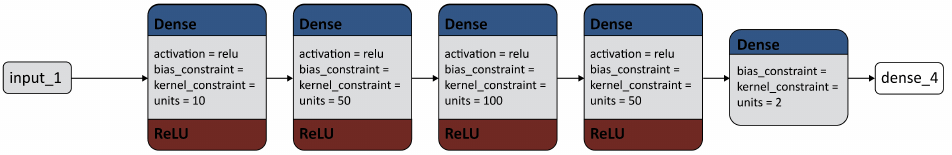
Figure 3. The algorithm of the internal architecture of the dense layers of the ReLU basic activation function of DL model.